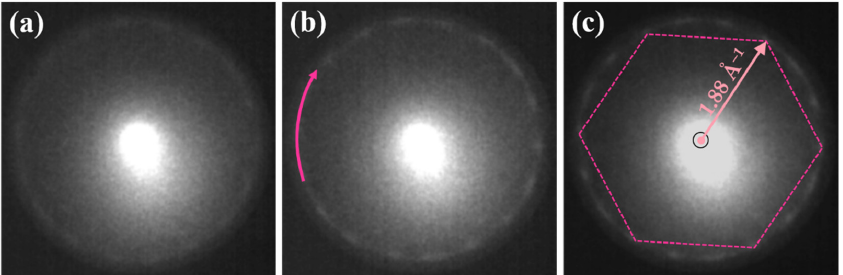
Figure 2. LEED patterns showing the thermal evolution of low buckled silicene recorded at RT ( a ), 410 K ( b ) and 420 K ( c ). The pink arrow in ( b ) indicates a ring with the diffraction spots of the low buckled silicene. The pink hexagon in ( c ) connects the spots of one of four domains. The black circle denotes the position of the (00) spot. All patterns collected at E = 14.2 eV.